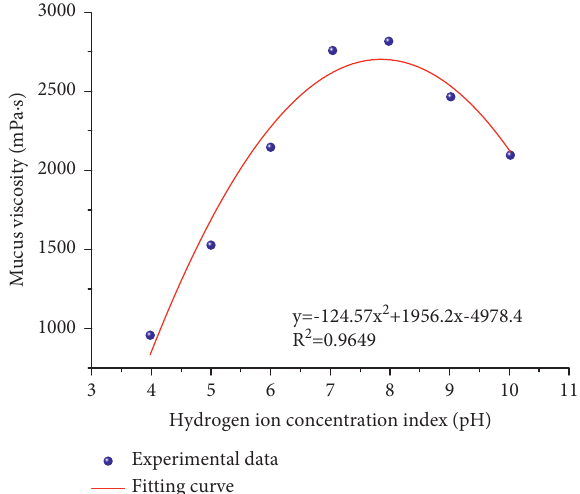
Figure 5: Change curve of the CMC-Na solution viscosity with pH. Figure 4: Variation in the CMC-Na solution viscosity with